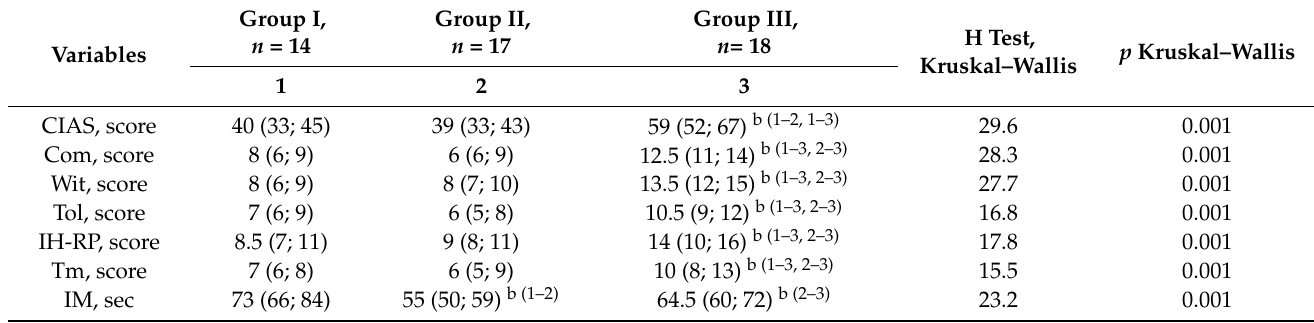
Table 1. CIAS subscale scores and IM duration in adolescents with different risks of IA a .